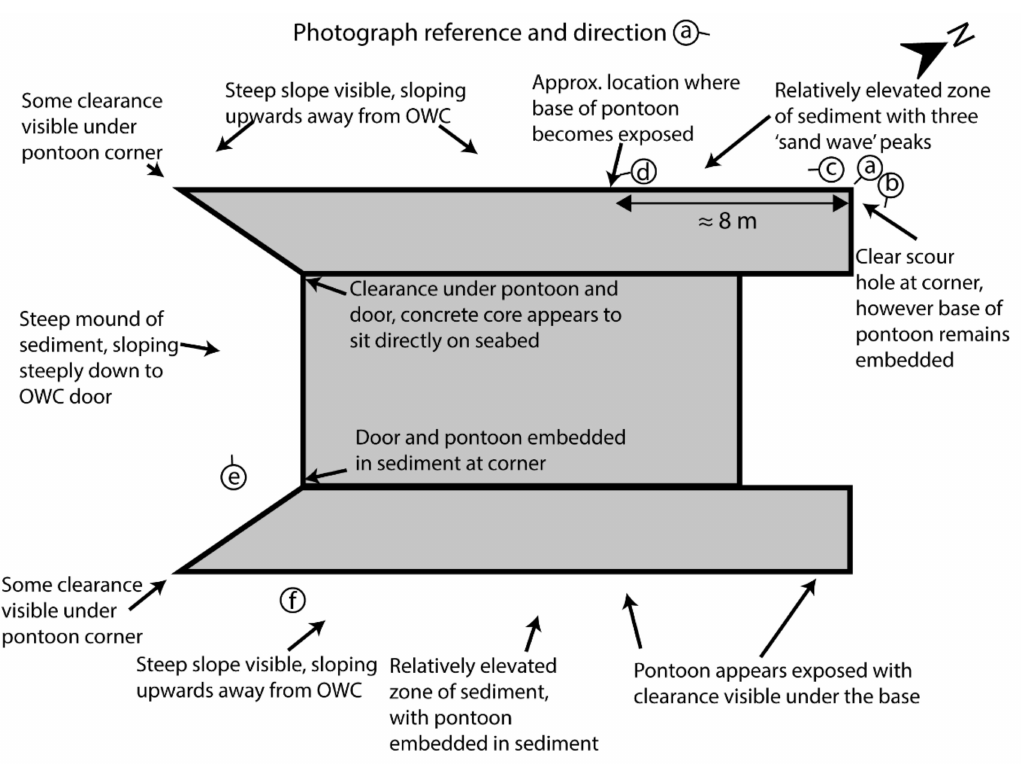
Figure 9. Plan sketch of observed scour and morphological changes around the OWC WEC at Location 2 on 1 February 2021. Not to